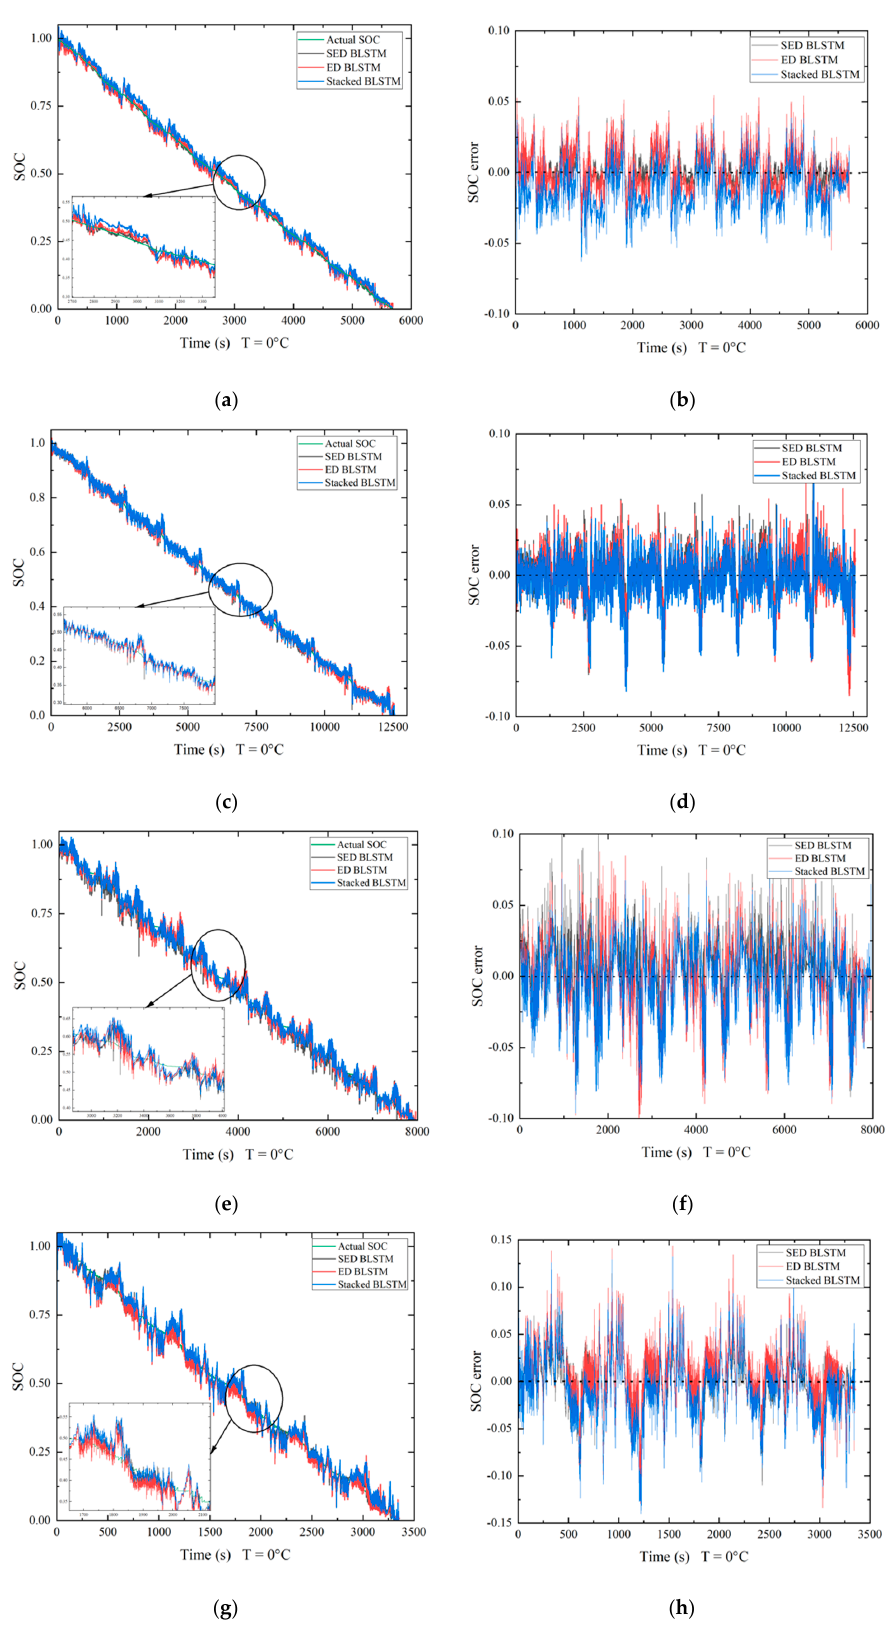
Figure 9. Predicted SOC comparison and SOC prediction error at 0 ° C. ( a , b ) HWFET. ( c , d ) UDDS. ( e , f ) LA92. ( g , h ) US06.